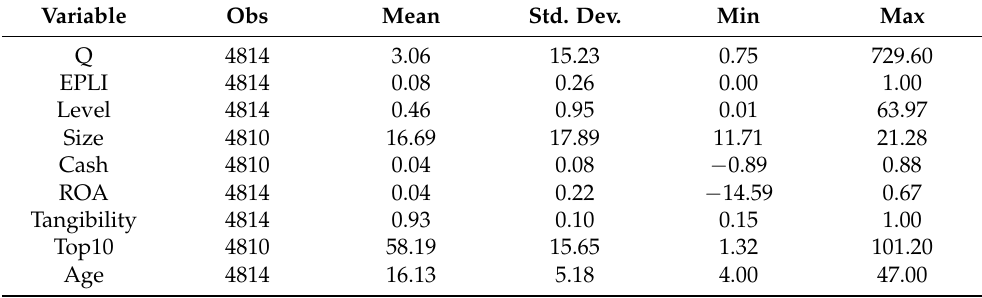
Table 3. Descriptive